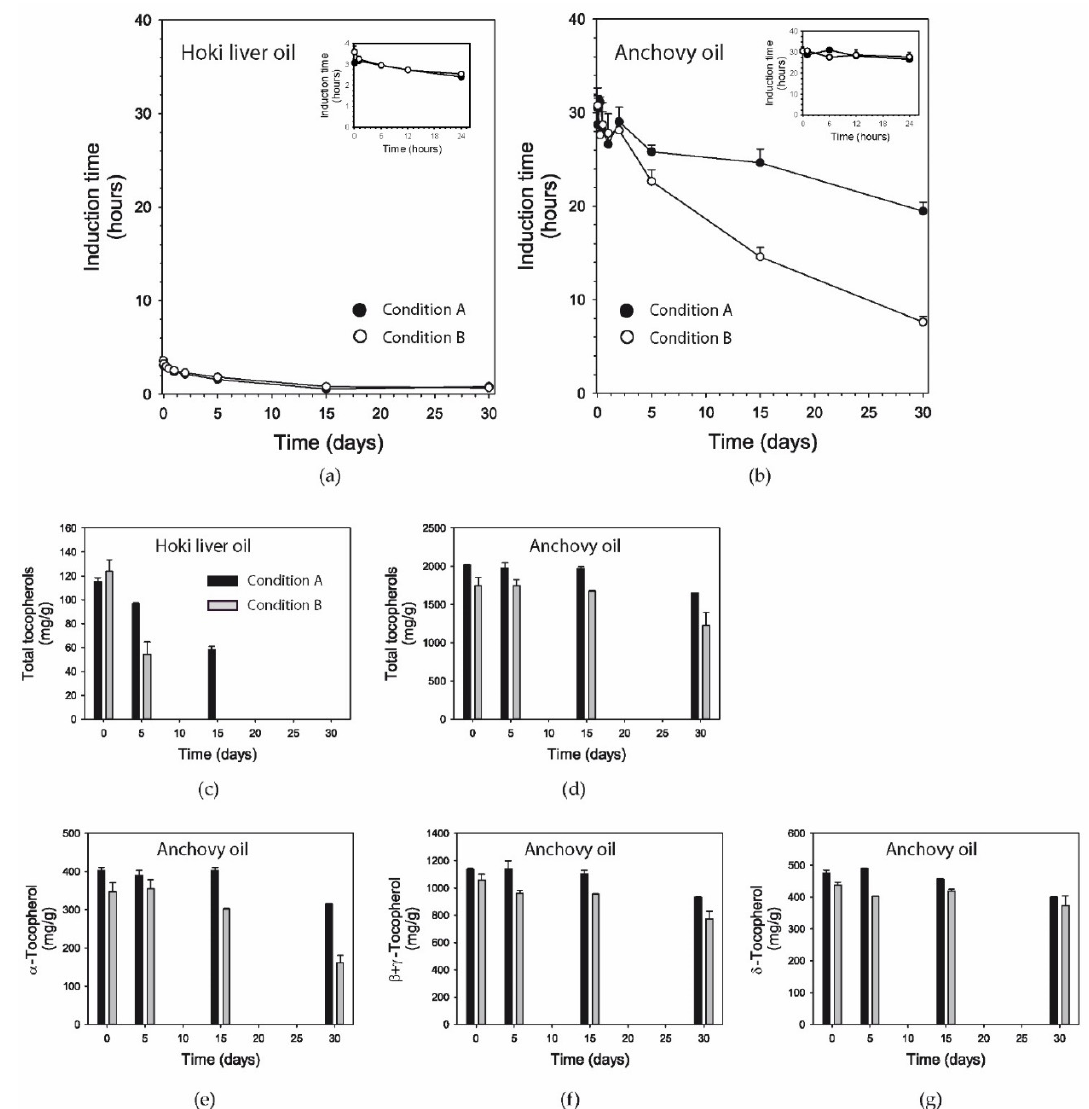
Figure 2. Induction time of ( a ) hoki liver oil and ( b ) anchovy oil over a 30-day period under Conditions A (black symbols) and B (open symbols). Total tocopherol concentrations in ( c ) hoki liver oil and ( d ) anchovy oil over a 30-period under Condition A (black bars) or B (gray bars). The specific tocopherols present in anchovy oil: ( e ) α -tocopherol, ( f ) β - plus γ -tocopherol), and ( g ) δ -tocopherol. In hoki liver oil, only α -tocopherol was present (i.e., the same as total tocopherol shown in panel c ). Results are means ± S.D. of three technical replicates for three parallel incubations.